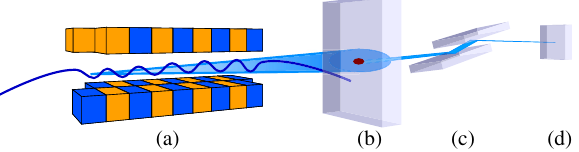
FIG. 2. Schematic of vertical undulator emittance measurement apparatus. This soft X-ray photon beam line is further described in Ref. [25]. (a) APPLE-II undulator in storage ring; (b) Pinhole aperture formed to spatially filter undulator radiation; (c) Grating monochromator to bandpass photon energy; (d) Silicon photo- diode to measure photon beam intensity.